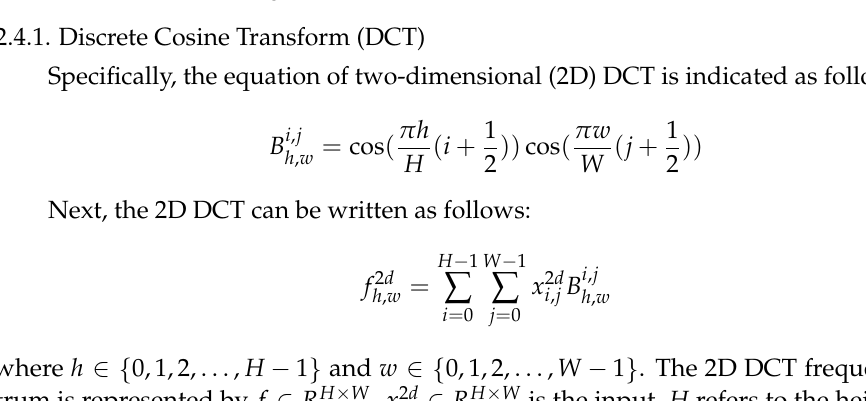
Figure 4. The schematic diagram of SFAM.